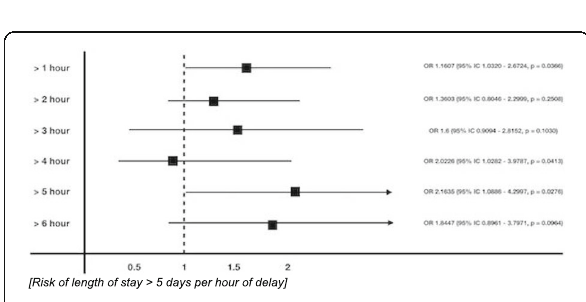
Fig. 2 (abstract 0260). Risk of length of stay > 5 days per hour of delay